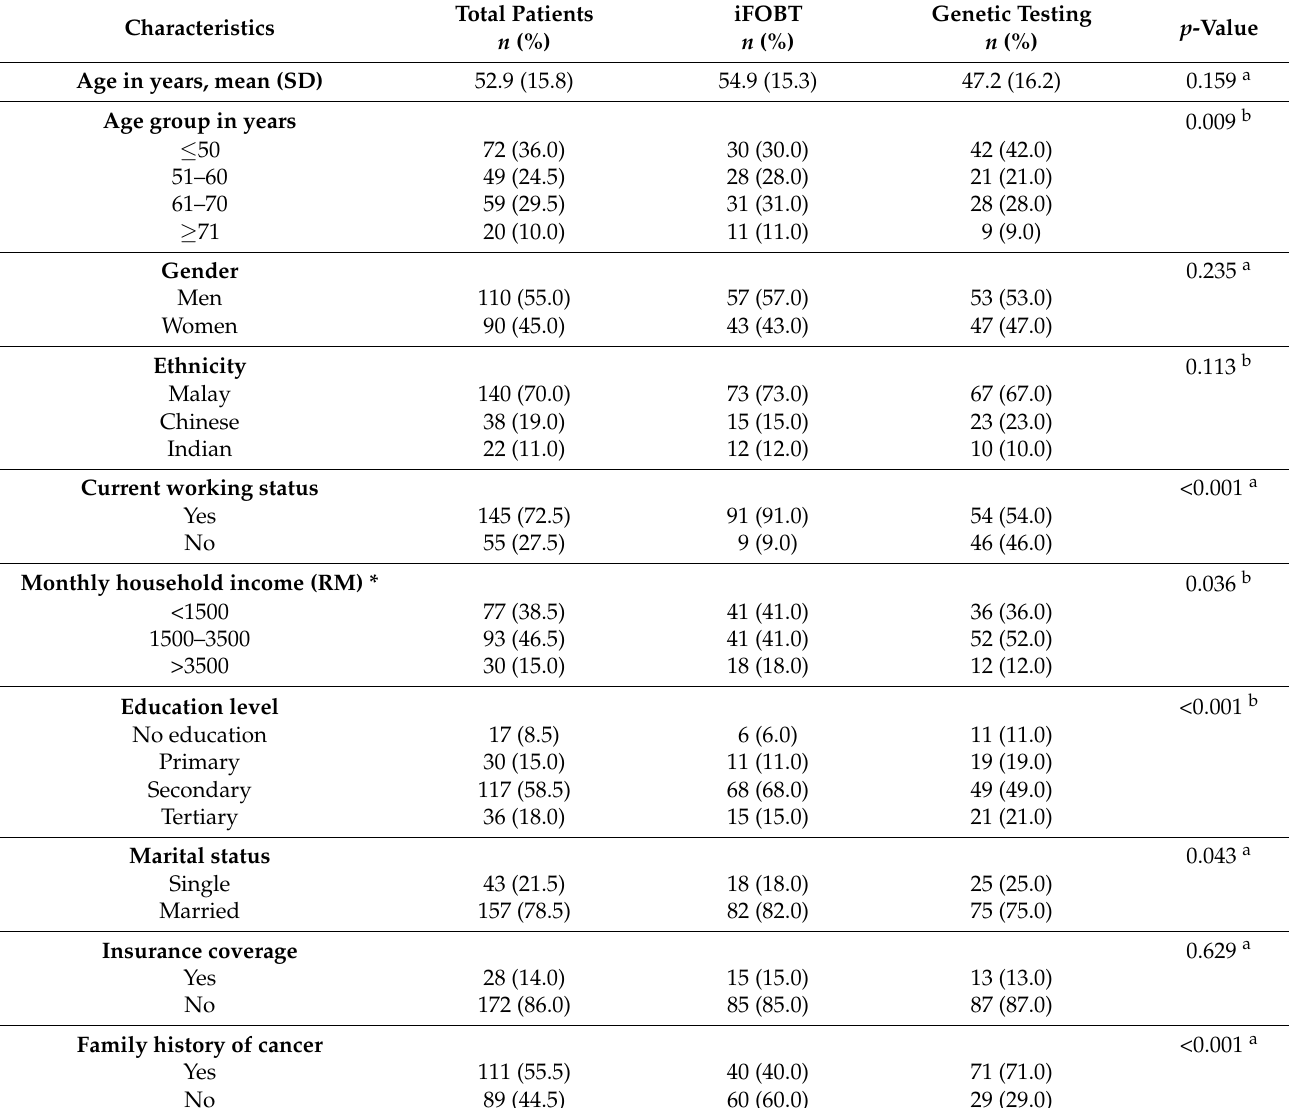
Table 1. Sample characteristics ( n =